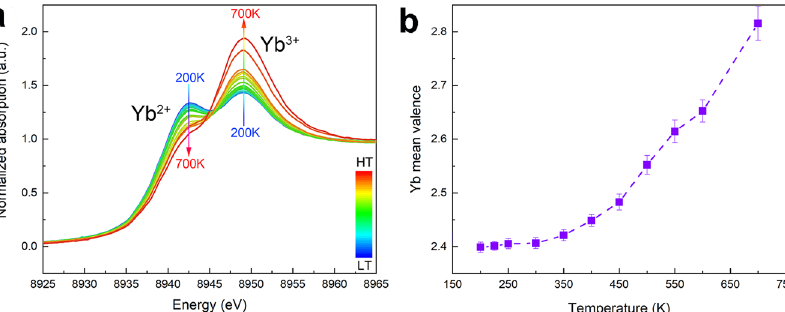
Fig. 3 The valence state characters of Yb. Temperature dependence of a the Yb L III -edge XANES spectra, and b the valence state of Yb in YbMn 2 Ge 2 . Error bars represent con fi dence intervals of valence